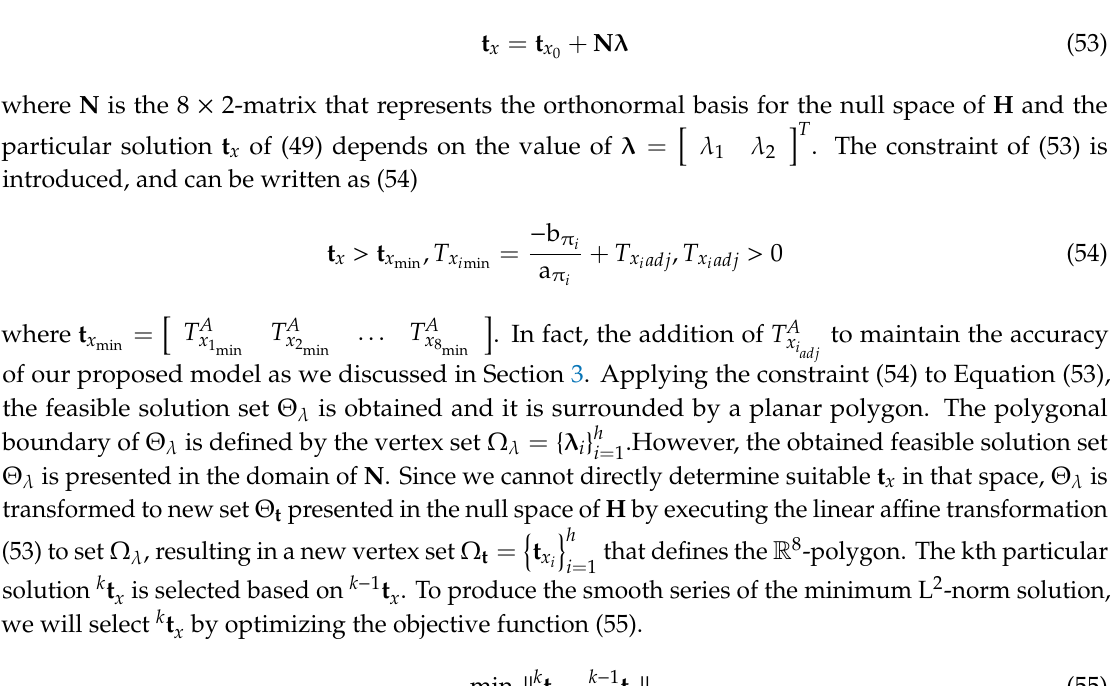
T and tension along Z - x